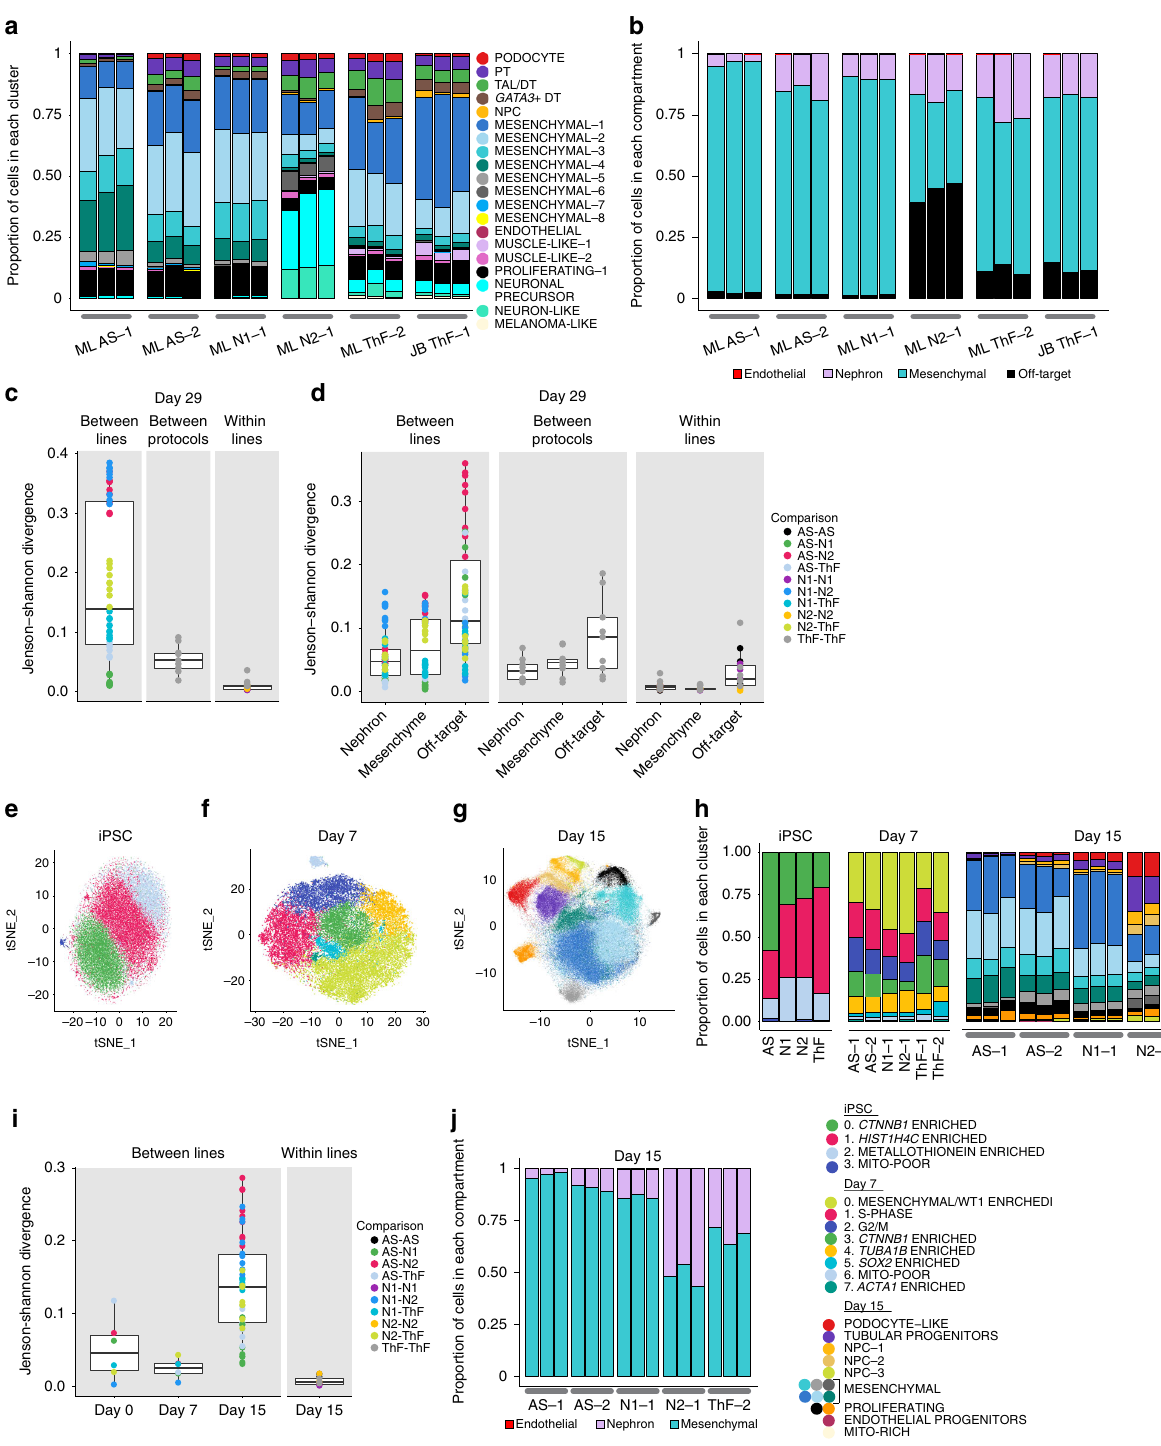
Fig. 3 Variability in cell type proportions detected by scRNA-seq evident at D15. a , b Relative proportions of endothelial, nephron, mesenchymal and off-target cell clusters across all replicates of D29 organoids. Annotations as shown. c , d Comparison of cell-type composition between D29 organoids as determined by boxplots of the Jenson − Shannon Divergence (JSD) scores. Each point on the plot is a pair-wise (color) measure of JSD between two organoids. Legend indicates annotation for pairs of iPSC lines. The center line of the boxplots indicates the median, and the bottom and top lines of the box indicate the fi rst and third quartiles respectively of the JSD scores. Outliers are indicated as dots beyond the whiskers; whiskers stretch up to + − 1.5*IQR on both sides. c Organoid compositional differences are greater between lines than between different protocols for the same line or between replicates of the same line and protocol (within lines). d Organoid compositional heterogeneity is greatest in the off-target compartment followed by the mesenchyme and the nephron compartment in all three comparison groups (between lines, between protocols and within lines). t-SNE plot of single cells from e iPSC, f D7, and g D15 of the organoid differentiation protocol. h Comparison of relative cell type proportion across iPSC lines of cell clusters shown in ( e − g ). i Compositional differences are greatest between lines at D15 and the least at D7. j Compartment-speci fi c cell-type proportions at D15 across all lines and